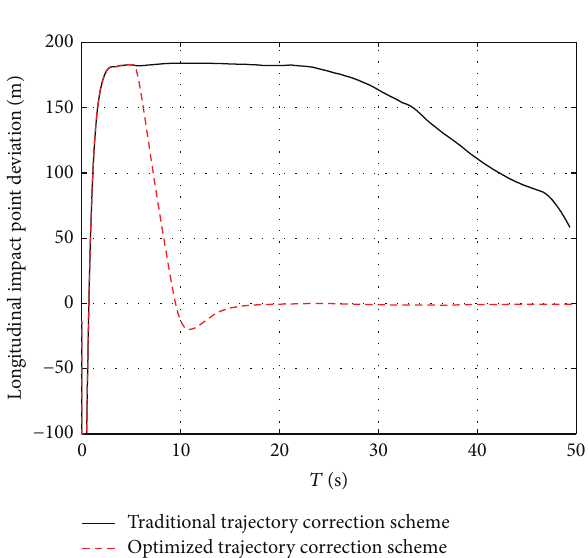
Figure 15: The change of longitudinal impact point